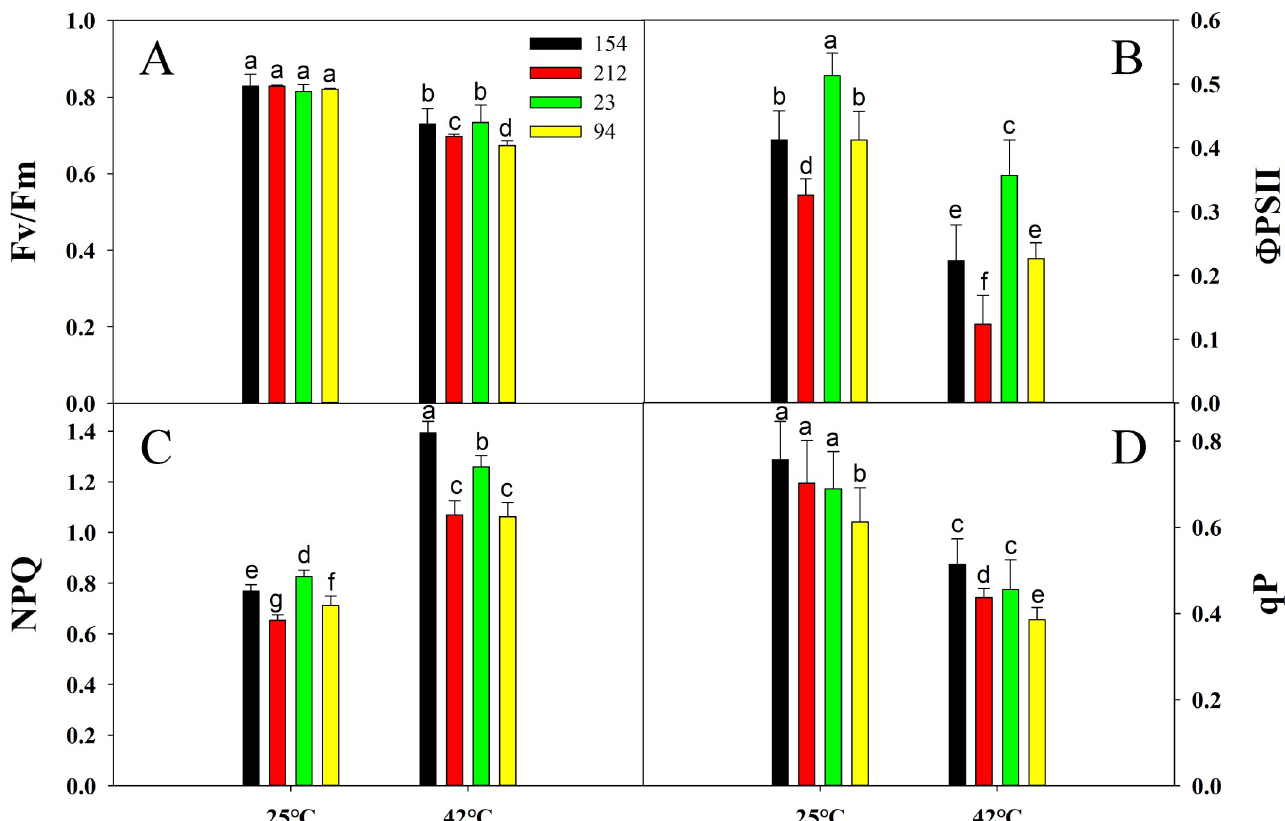
Fig 3. Effects of heat stress (treatment at 42˚C for 4 h) on (A) Fv/Fm, (B) actual photochemical efficiency ( Փ PSII), (C) nonphotochemical quenching (NPQ), and (D) qP in leaves of NILs. Lines 154 and 23 possess high photosynthetic rates; Lines 212 and 94 possess low photosynthetic rates. The values are the mean ± SE from three independent experiments. Different letters indicate significant differences at P =